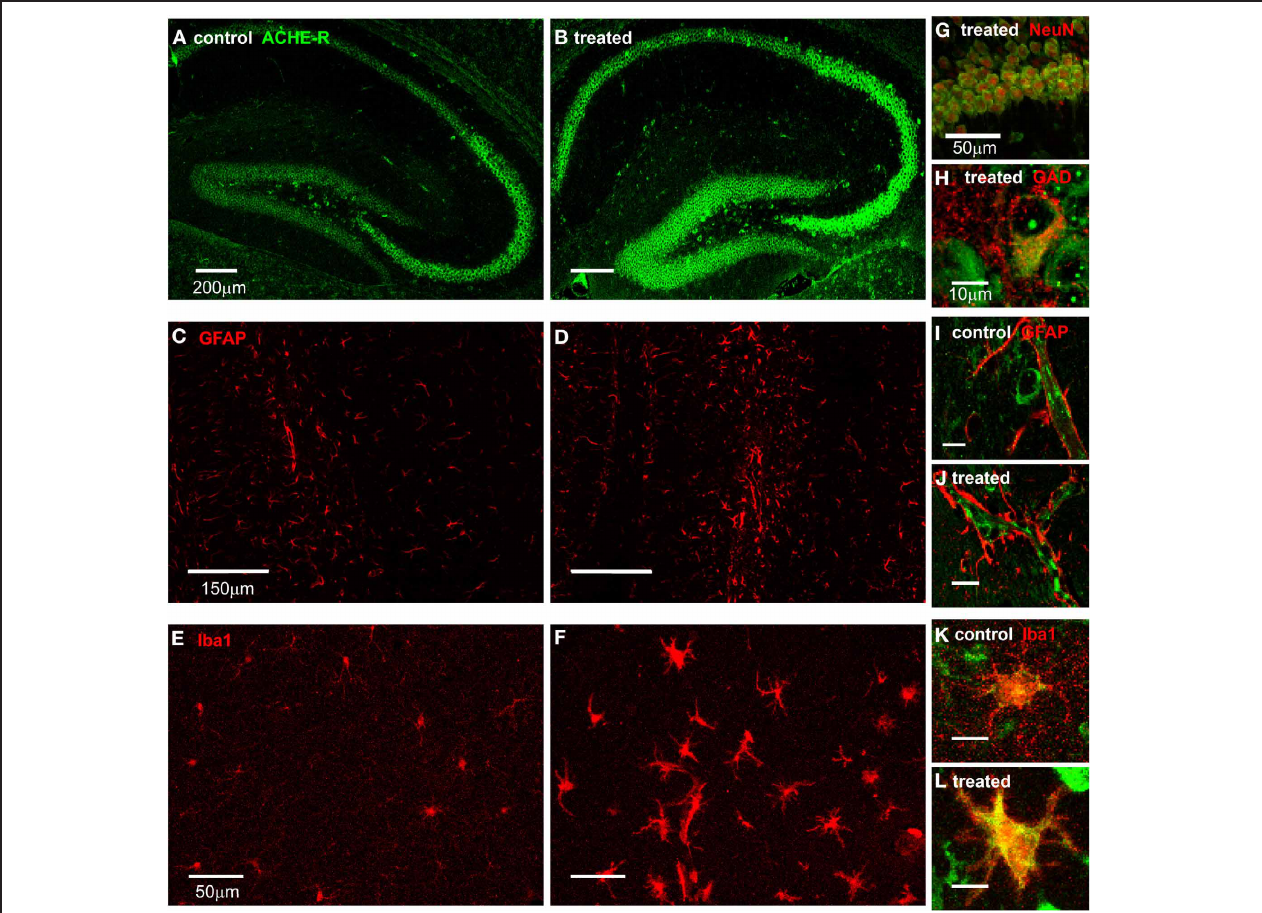
the hilus of a treated animal. (I,J) Double labeling of AChE (green) and GFAP (red) in hippocampus of control (I) and treated (J) mice (scale 10 μ m). Note the clear positive AChE staining in the blood vessel and the endothelial cells but not in the end fit of GFAP-positive astrocytes surrounding it. (K,L) Double labeling of AChE (green) and Iba1 (red) in hippocampus of control (K) and treated (L) mice (scale 10 μ